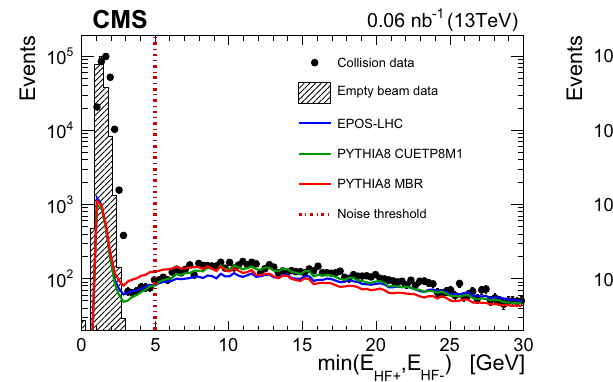
Fig. 1 Distributionoftheabsolutenumberofeventsasafunctionofthe highest energy tower, E HF + and E HF − , in the HF + and HF − calorime- ters.TheleftpanelshowsthesmallerofthetwoHFcalorimeterenergies, min( E HF − , E HF + ), whereas the right panel shows the higher of the two